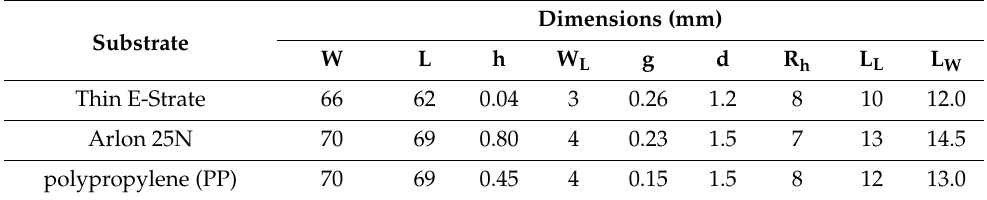
Table 2. Dimensions of the CPW-fed monopole antenna for di ff erent dielectric substrates.